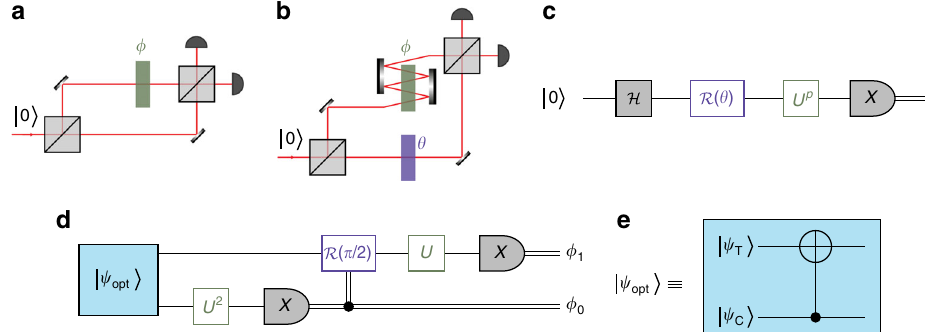
Fig. 1 Optical phase measurement concept. a Basic interferometric setup for estimation of an unknown phase ϕ . b Conceptual scheme of an advanced interferometer that includes multiple ( p ) passes of the phase shift ϕ and a controllable phase θ in the reference arm. c Quantum circuit representation of the interferometer shown in b . The interferometer is represented by a Hadamard gate H and a projective measurement in the X -basis, and the application of reference and unknown phases ( p passes) is represented by unitary operators Rð θ Þ and U p , respectively. d Quantum circuit for Heisenberg-limited interferometric phase estimation with N = 3 resources. The protocol is extensible to higher N , in principle 15 . e Quantum circuit for the preparation of the optimal state j ψ i , Eq. (2), using a CNOT gate with control and target qubits prepared in j ψ opt